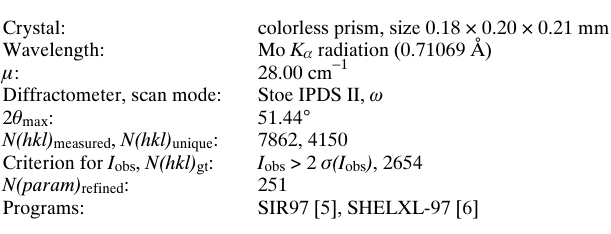
Table 1. Datacollection and